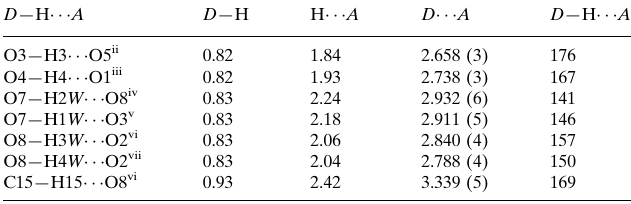
In the centrosymmetric eight-coordinated in a PbO from the 1,10-phenanthroline (phen) ligand, five carboxylate O atoms from four 3-hydroxybenzoate anions and one O atom